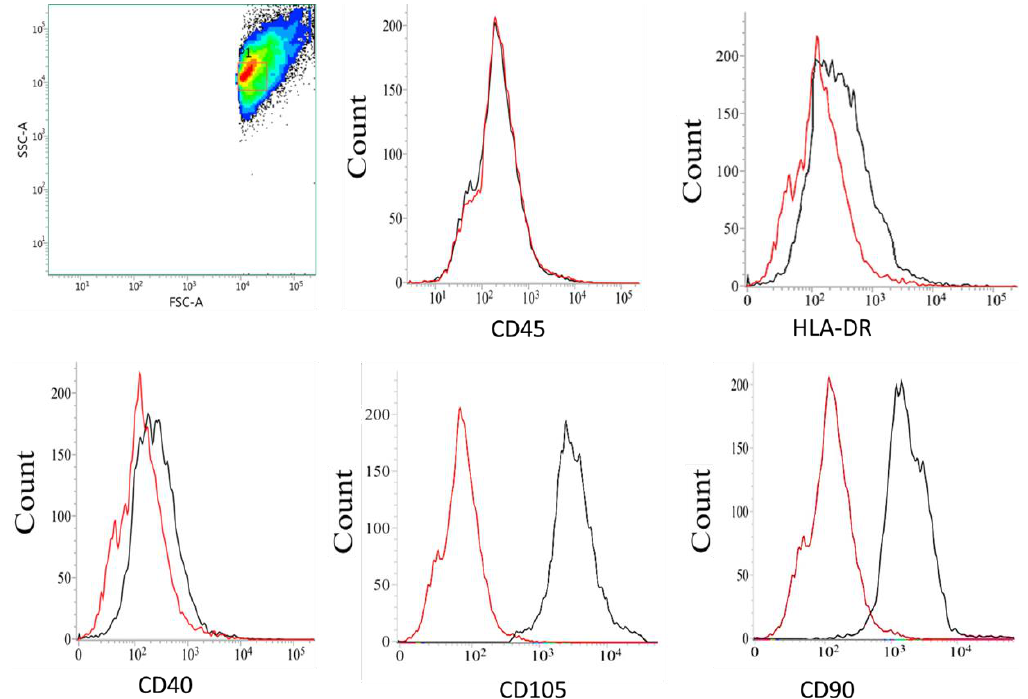
Figure 1. Immunophenotyping characterization of mesenchymal stem cells (MSCs) by flow cytometric analysis. Fluorescence-activated cell sorting (FACS) results confirmed that MSCs were homogenously positive for mesenchymal cell surface markers CD105 and CD90, but negative for hematopoietic cell surface marker CD45, leucocytes cell surface marker HLA-DR and macrophage cell surface marker